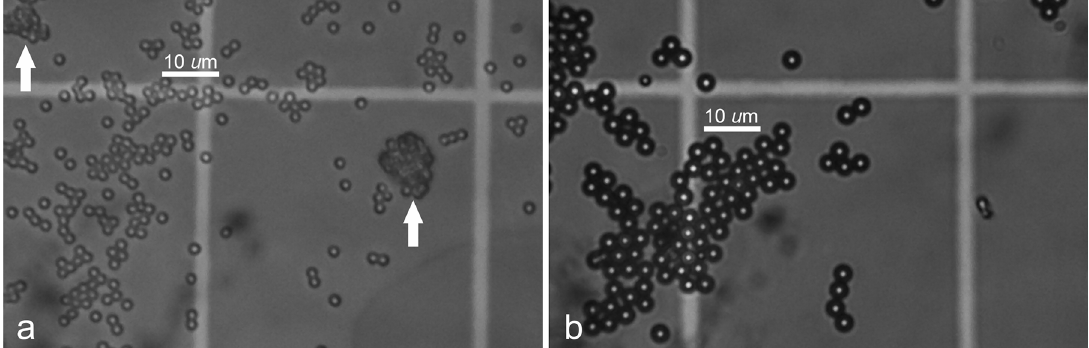
Figure 1. Optical microscopy of polymer particles prepared with acetonitrile/toluene volumetric ratio of 75/25 and molar fractions of: (a) 80% methacrylic acid and (b) 23% methacrylic acid. The presence of particle agglomeration in "(a)" (arrow) is observed. (400 X